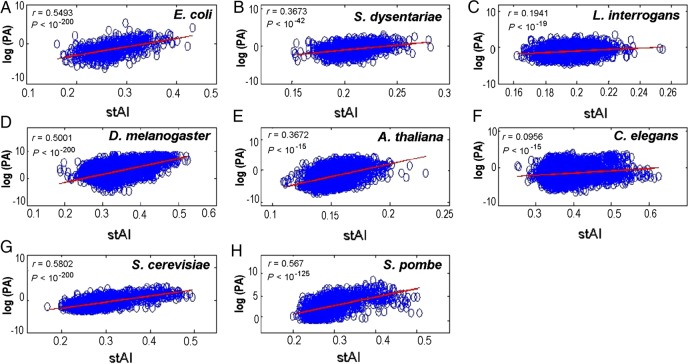
Dot plots of log(PA) vs. stAI and the corresponding Spearman rank correlations between stAI and PA. The correlations (and P-values) are calculated for the eight model organisms with PA measurements which include three bacteria (A–C), three non-fungal eukaryotes (D–F), and two fungi (G–H).